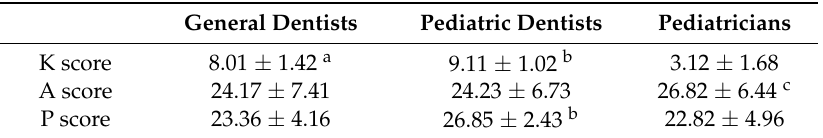
Table 3. Mean KAP scores in three